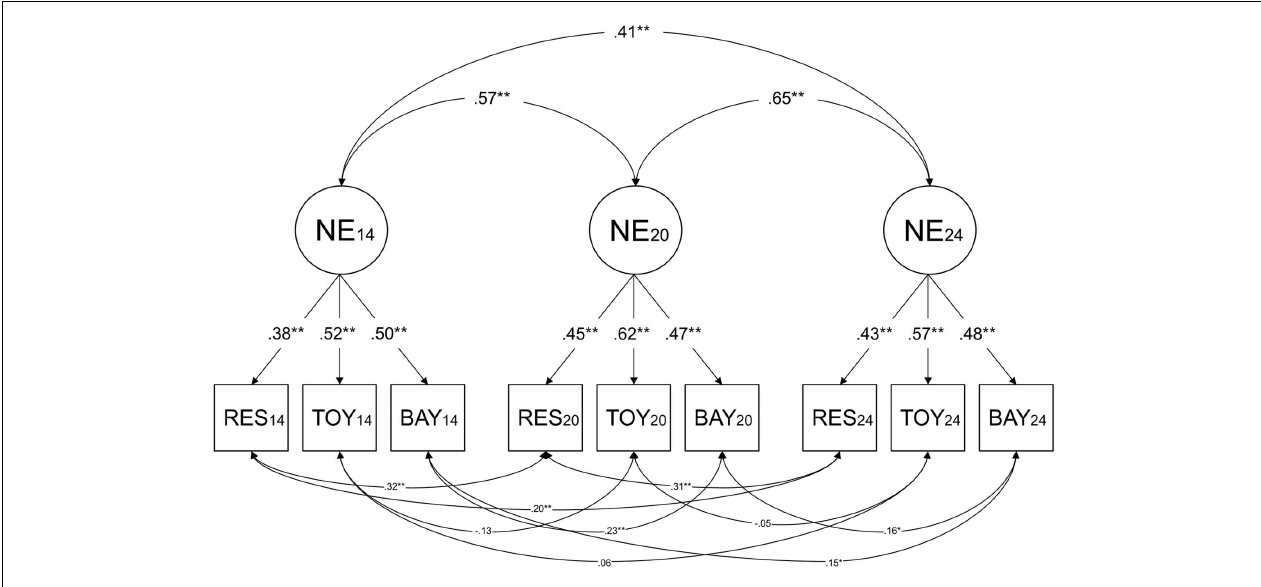
FIGURE 1 | Results of confirmatory factor analysis of negative emotionality at age 14, 20, and 24months. NE 14 , NE 20 , and NE 24 = latent negative emotionality at 14, 20, and 24months; RES 14 , RES 20 , and